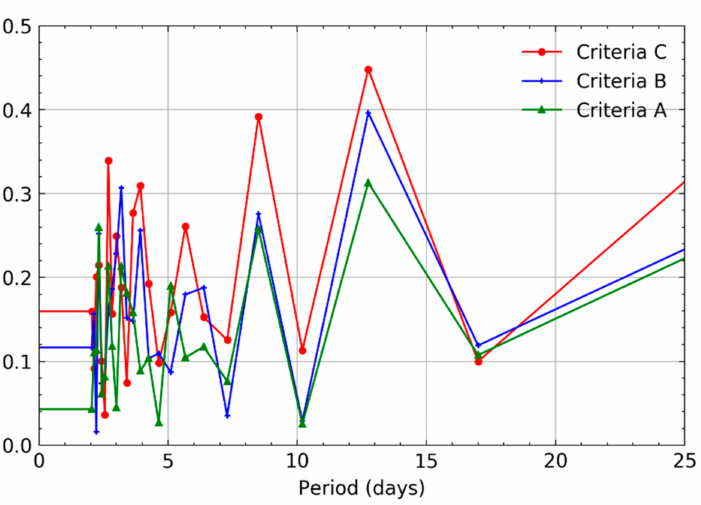
Figure 10. Fast Fourier Transform of mean night TEC values during index days at IGS Noto. When compared to distant locations, mean TEC values at IGS Noto show increased amplitude and standard deviation. The most prominent anomalous TEC values were found during the activity of Criteria C around the fifth day before the VAI. It can also indicate that the major volcanic activity caused larger deviations in the ionospheric TEC values, when compared to minor- or no-activity periods. Figure 11. The majority of data distribution is similar between two datasets: during the day of VAI (Figure 11a) and 5 days before (Figure 11b). The lack of large histogram values additionally suggests that the outlier values have not significantly influenced the